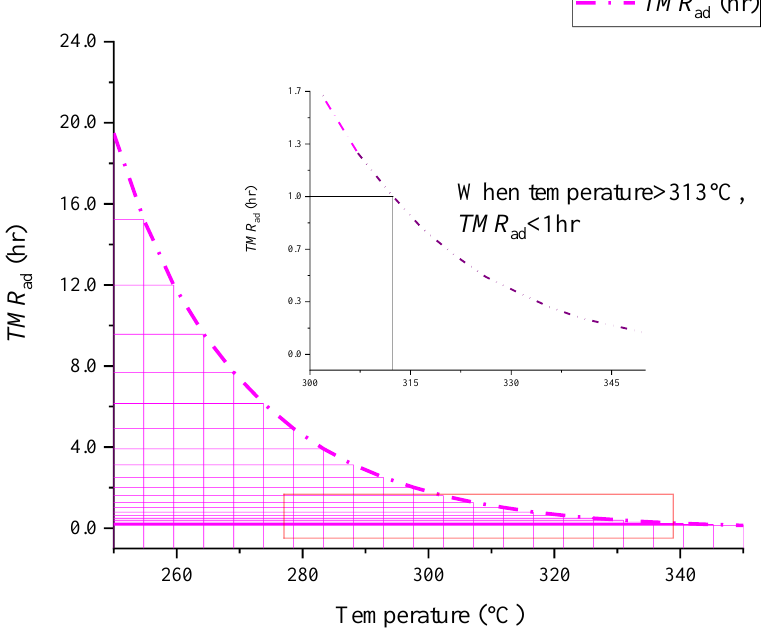
Figure 6. Evaluation of TMR ad values of [BZMIM][TF2N] at different initial temperatures under adiabatic conditions.